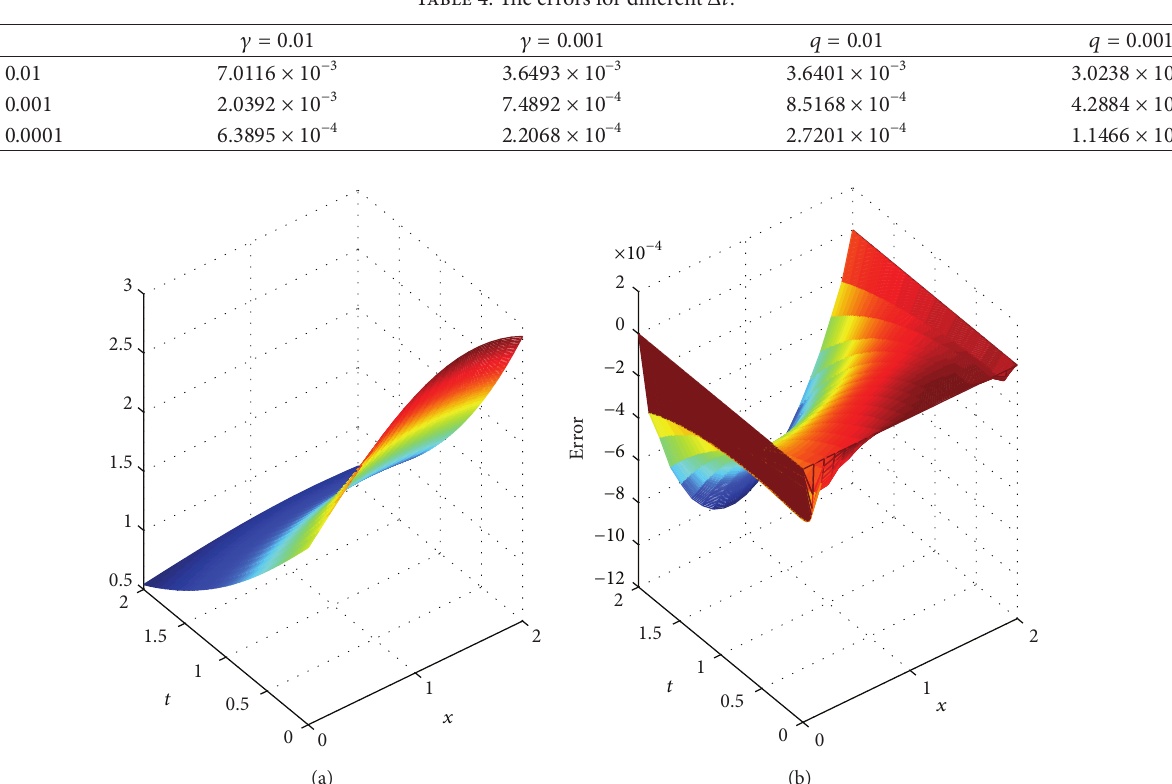
Figure 7: The numerical solution of ̂𝑢(𝑥,𝑡) (a), the error 𝑢(𝑥,𝑡) − ̂𝑢(𝑥,𝑡) (b) with Δ𝑥 = 0.1 , Δ𝑡 = 0.001 .